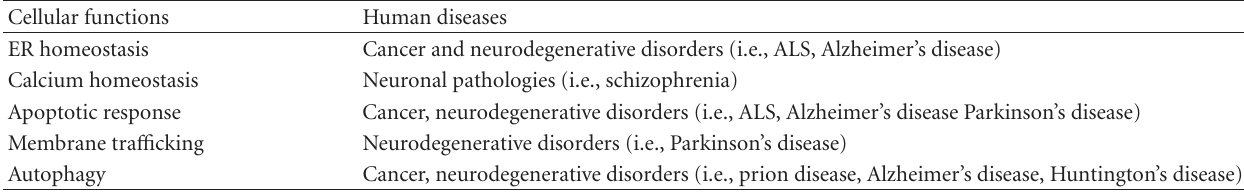
Table 1: Correlation between some RTNs cellular functions and their potential involvement in di ff erent human